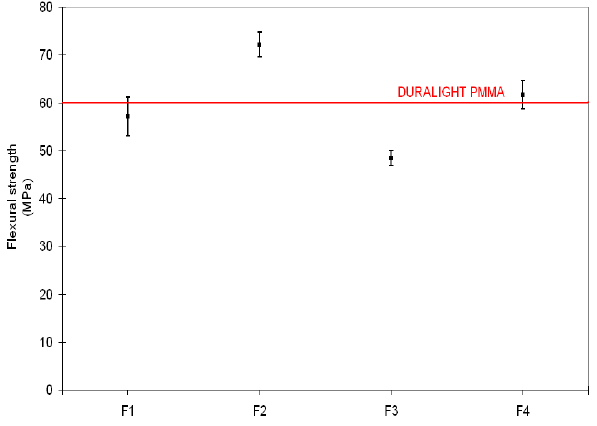
Figure 2. Flexural strength results.